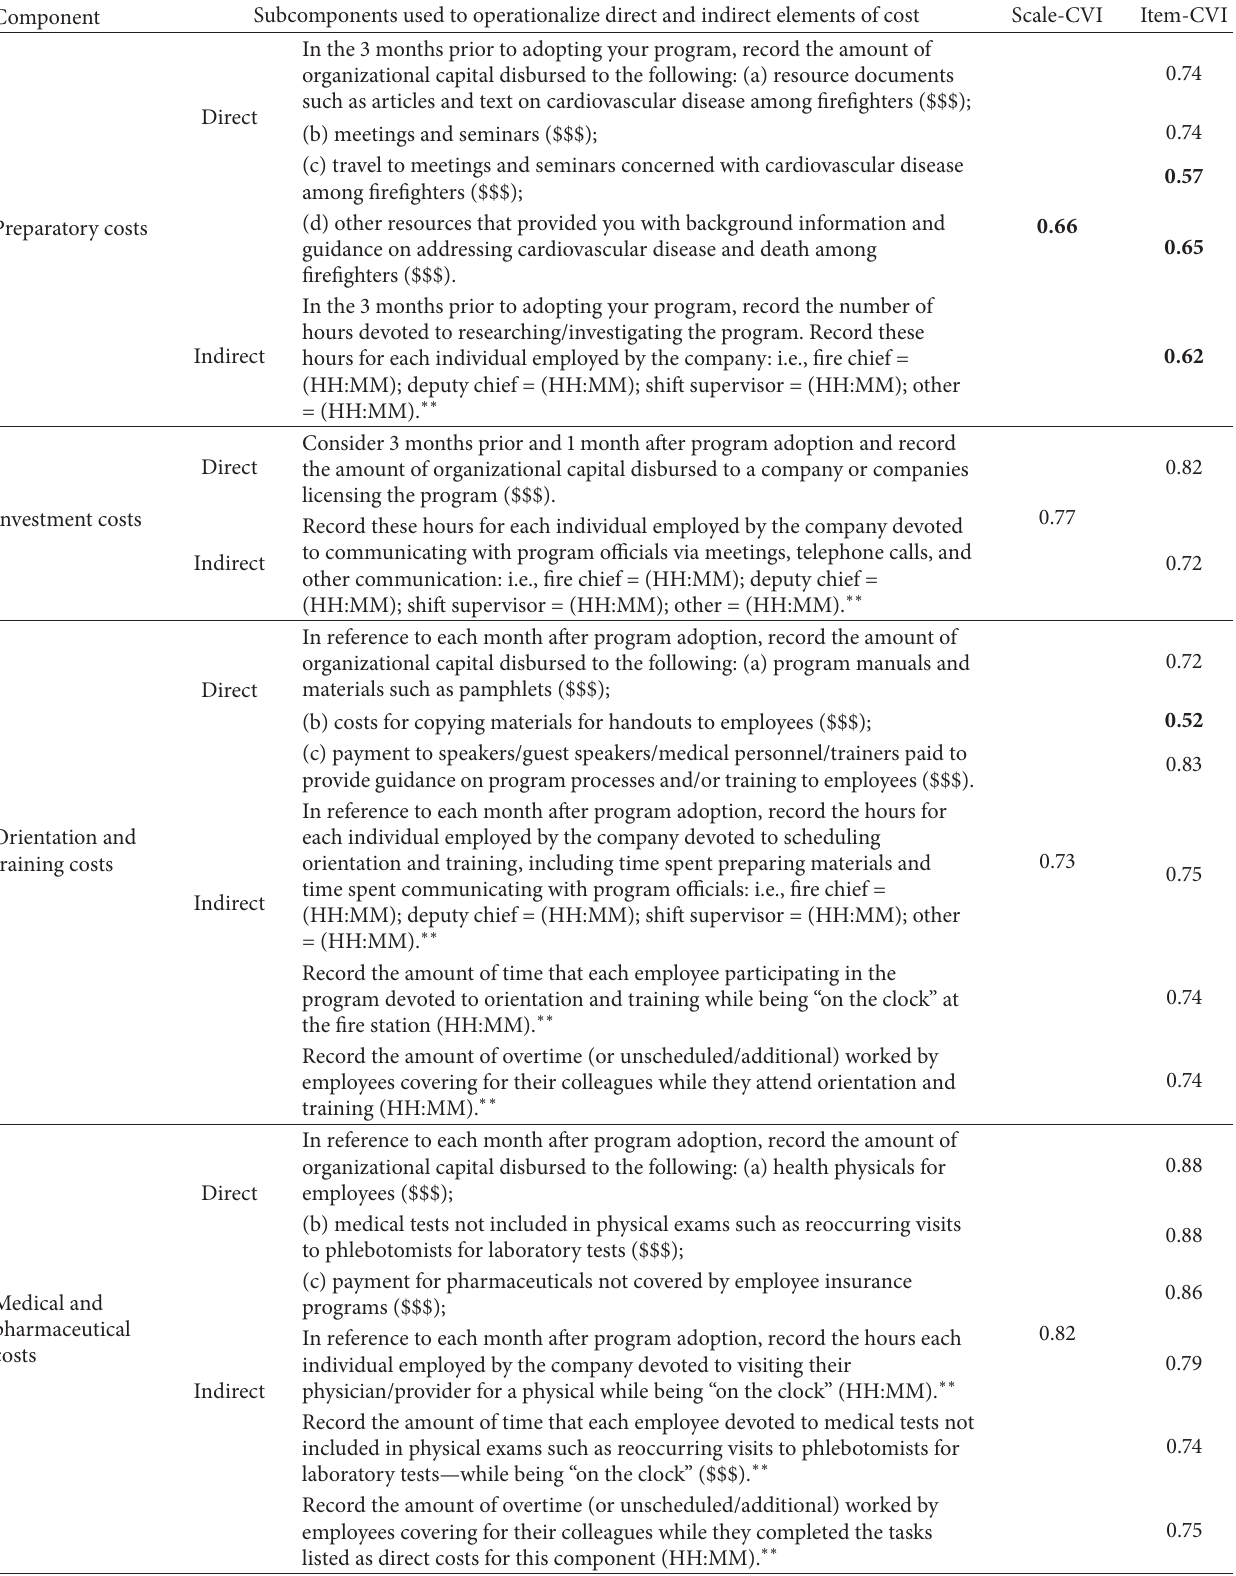
Table 1: Content validity scores for each draft component (direct and indirect) of the method for calculating costs.